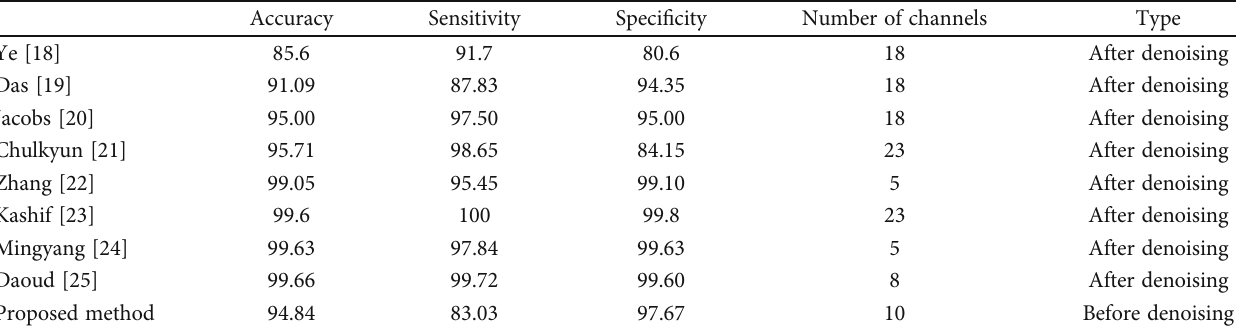
Table 7: Test performance comparison.